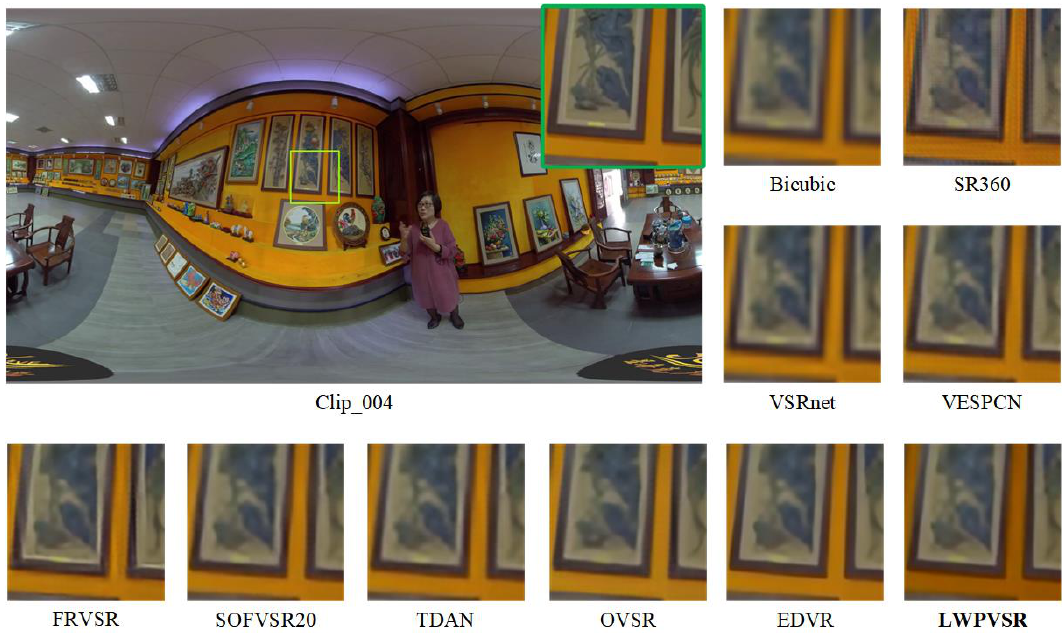
Figure 9. The results of all the algorithms performing 4 × super-resolution on Clip_004 of the MiG test